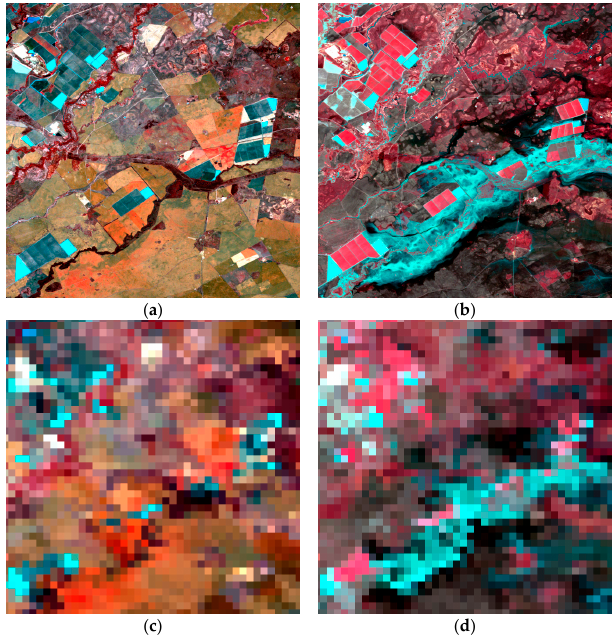
Figure 3. The second dataset exhibiting land cover changes: NIR-red-green composites of the Landsat images with a 30-m spatial resolution from ( a ) 26 November 2004 and ( b ) 28 December 2004; the corresponding MODIS images with a 500-m spatial resolution from ( c ) 26 November 2004 and ( d ) 28 December 2004.